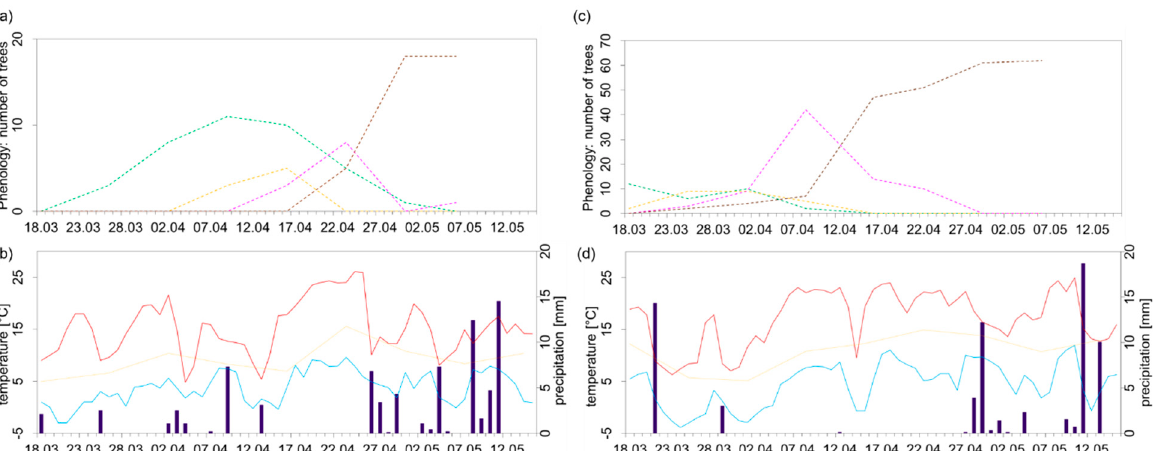
Figure 3. Weekly pollen catch (pollen grains/cm 2 ) presented with a logarithmic scale on the y -axis for horizontal and vertical slides attached at four pollen traps for at the location Schorndorf in 2019 (solid black line) and 2020 (dashed black line).